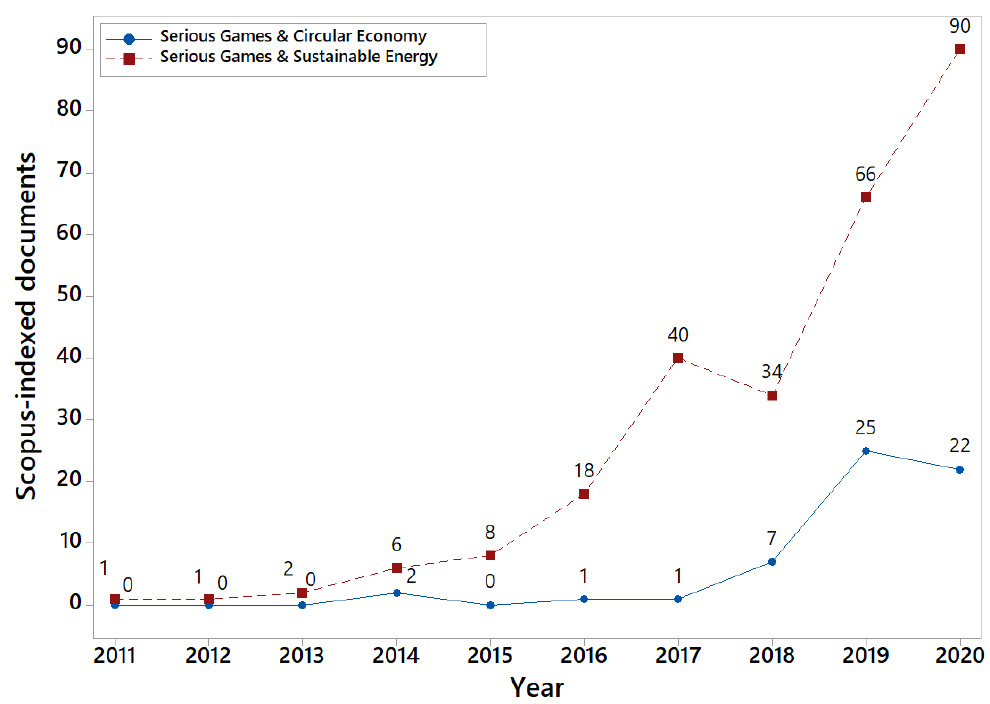
Figure 4. Scopus-indexed documents on “Serious Games” and (“Circular economy” or “Sustainable